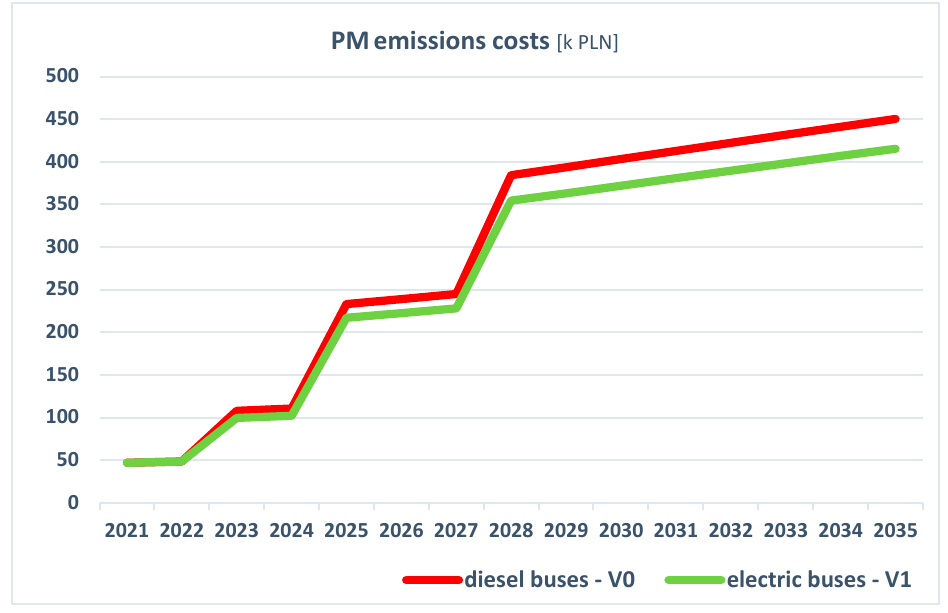
Figure 6. Projected amounts of PM emissions costs of the public bus fleet in Szczecin in the 2021–2035 period for variants V0 and V1.